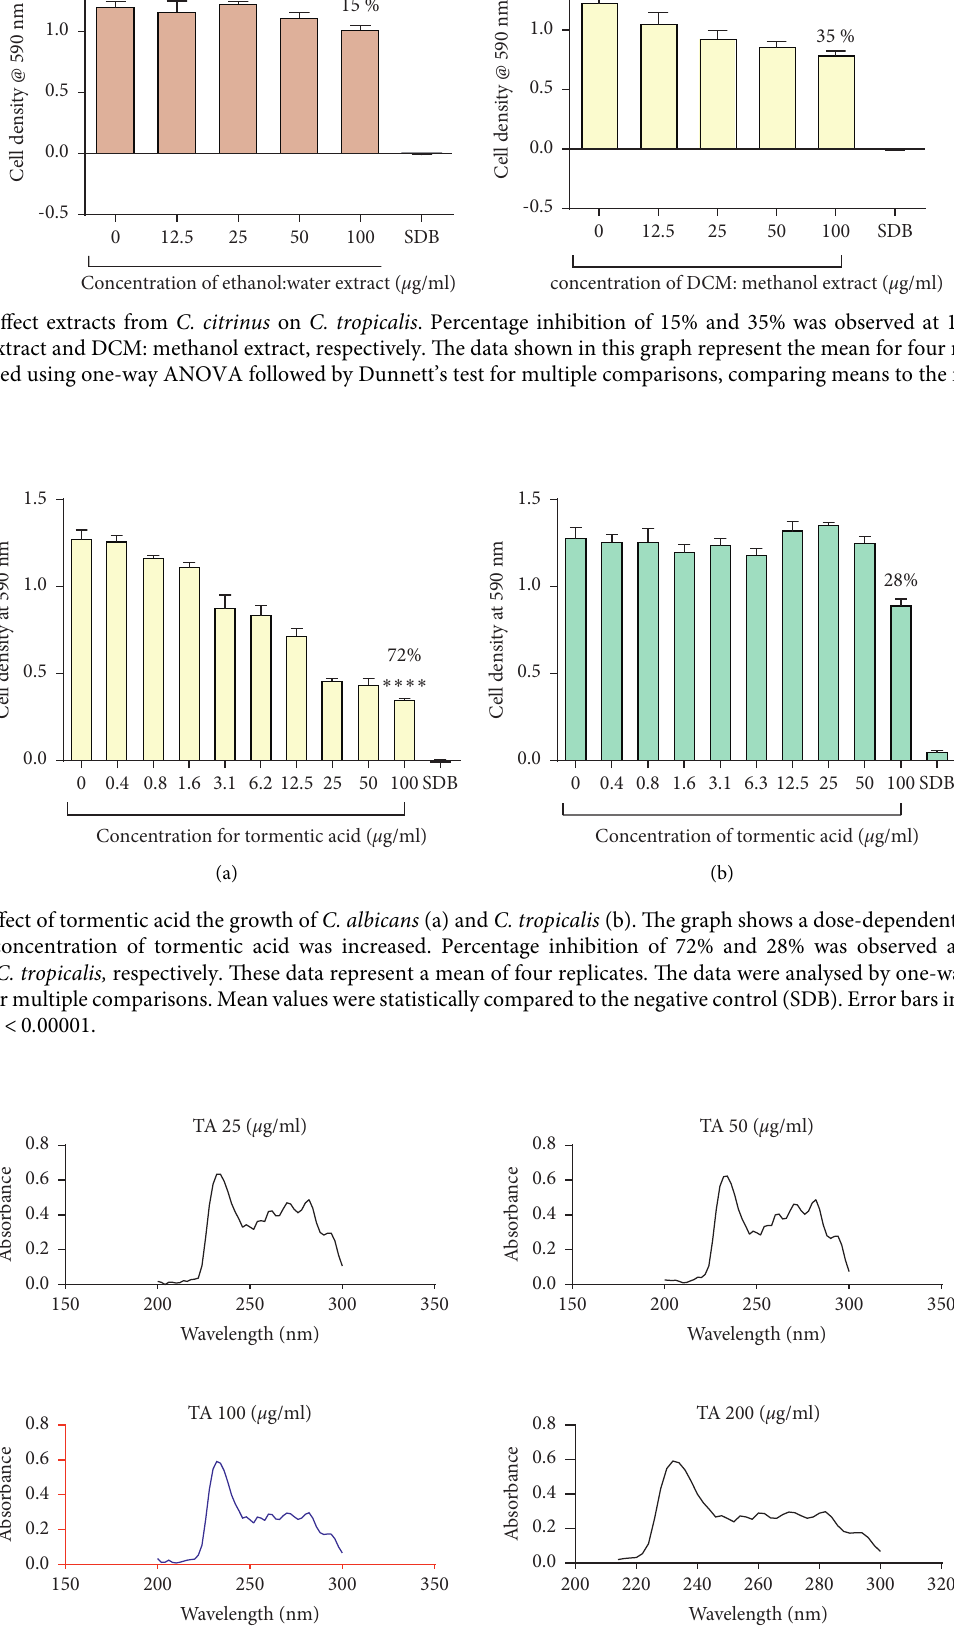
Figure 8: Absorbance spectra of ergosterol from C. albicans cells exposed to tormentic acid. Cell pellets of C. albicans were exposed to 25 μ g/ ml, 50 μ g/ml, 100 μ g/ml, and 200 μ g/ml of tormentic acid (TA). The graphs show the UV/Vis scan of the extracted sterols from 200nm to 300nm. There was a similar spectra pattern, and a general decrease with increased concentration of tormentic acid was